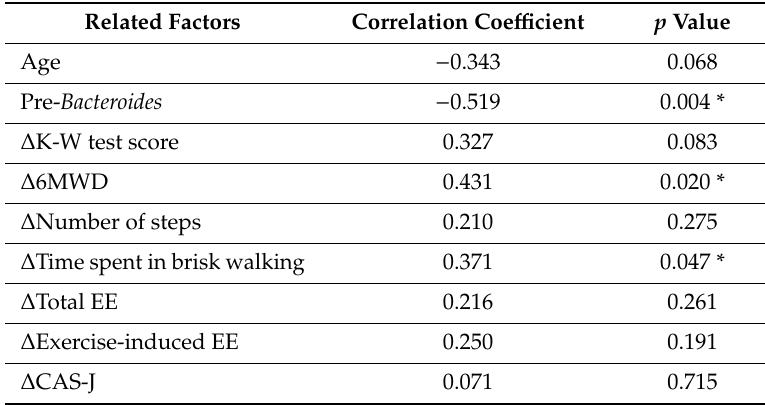
Table 4. Correlation coe ffi cients in simple regression analysis between clinical factors and the changes in the relative abundance of intestinal Bacteroides following the exercise intervention in all subjects.